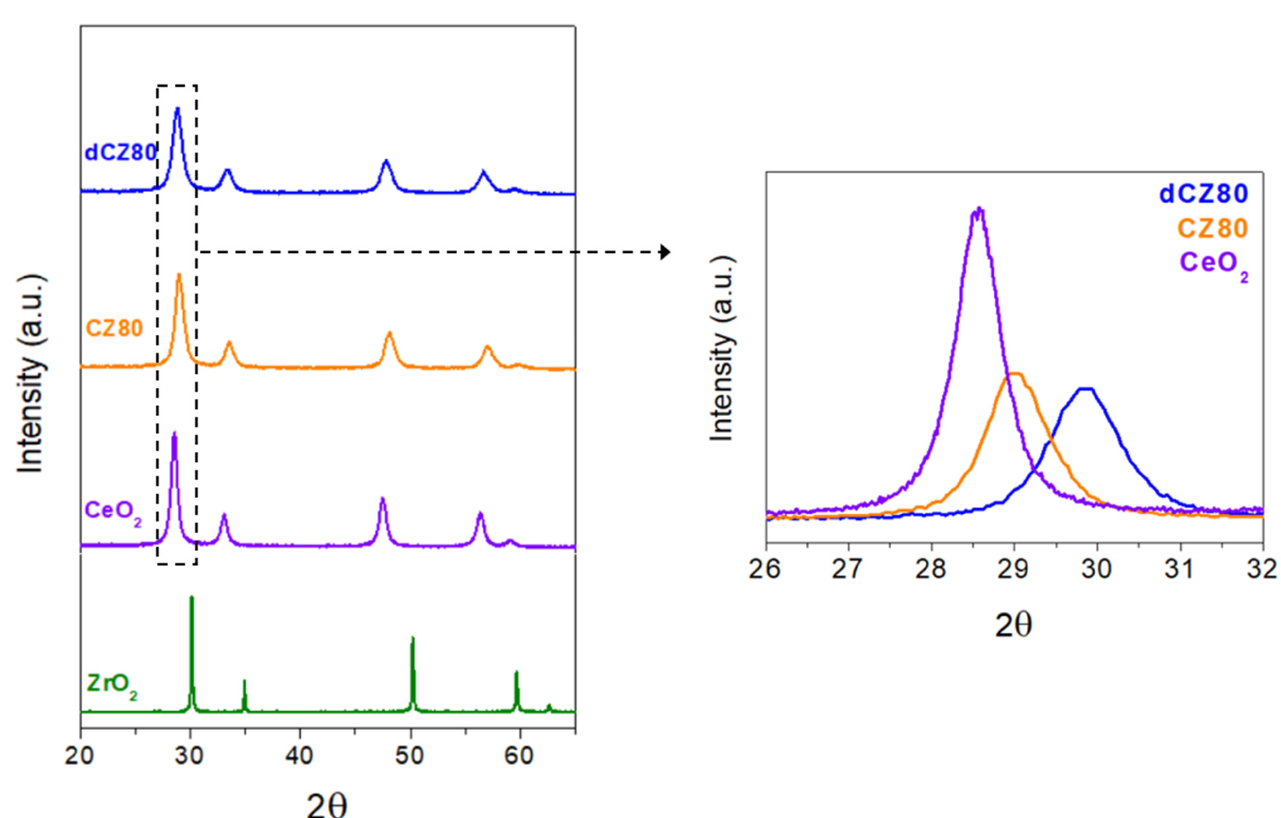
Figure 1. XRD spectra of ceria–zirconia supports, undoped and doped.